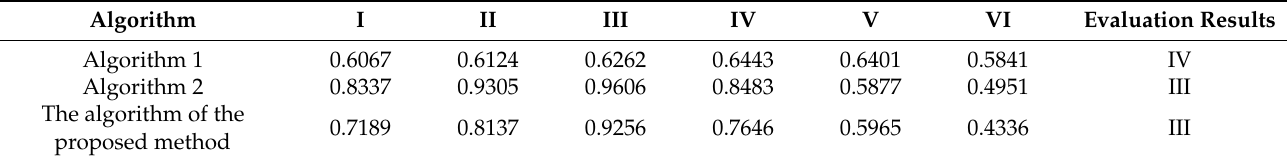
Table 9. Evaluation results of different algorithms in the paddy rice